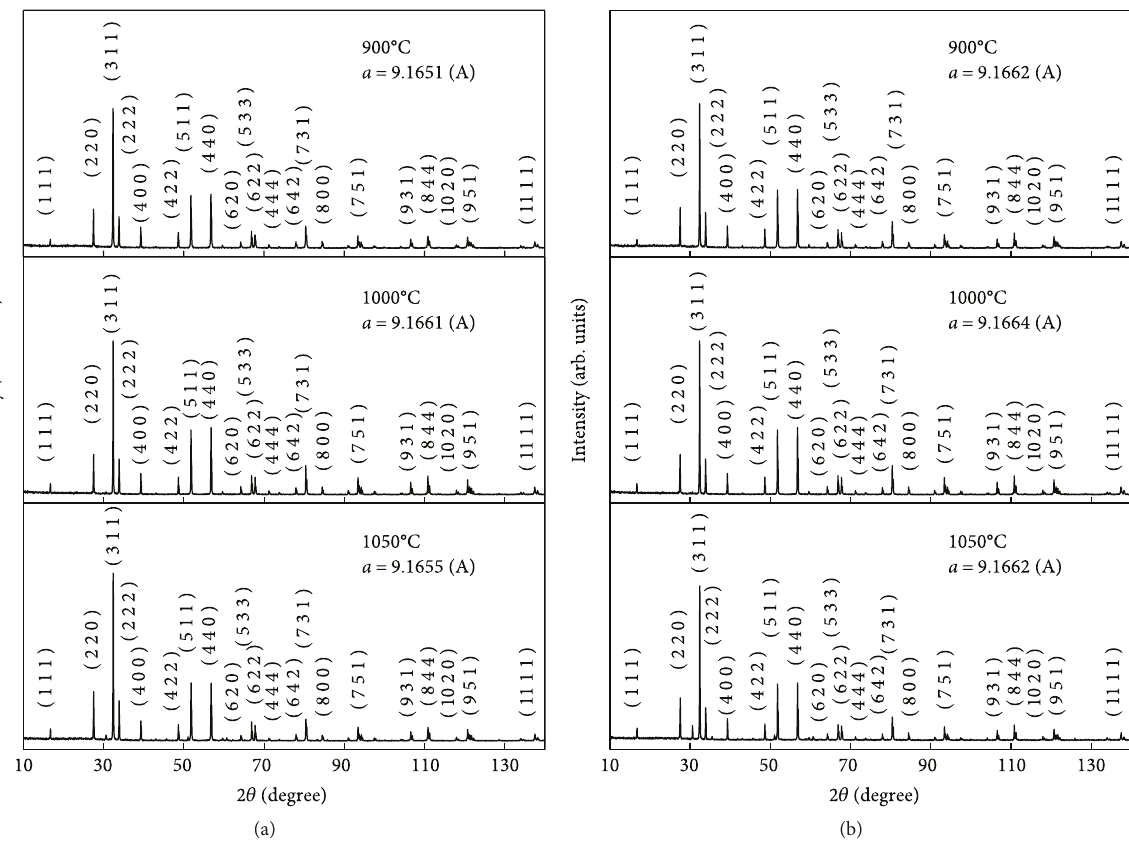
O (a) and CdIn 2 4